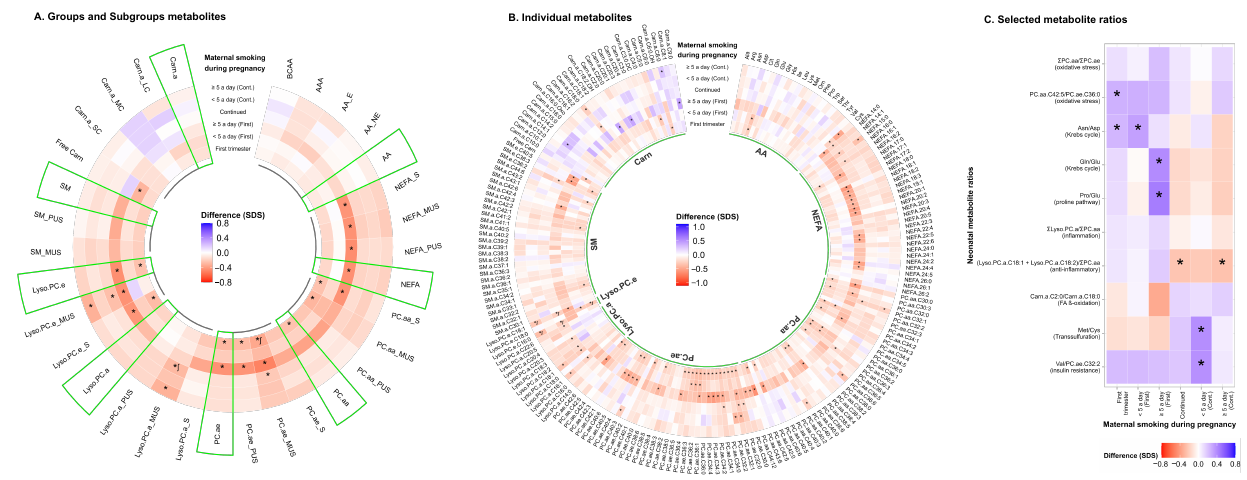
Figure 1. Associations of maternal smoking during pregnancy with cord blood metabolite profiles and ratios. Values represent regression coefficients based on linear models that reflect the positive (blue) and negative (red) difference in neonatal cord blood metabolite concentrations and ratios in standard deviation scores in neonates whose mothers smoked during pregnancy compared to mothers who did not smoke. Models were adjusted for maternal age, educational level, alcohol consumption, pre- pregnancy BMI, psychopathology symptoms, and fetal sex (confounder model). * p -value < 0.05. S Sig- nificant associations after FDR corrected p -value. The sectors of green color showed group of neonatal metabolite profile, which is preceded by metabolite profile subgroups. Abbreviations: SDS, standard deviation scores; BMI, body mass index; AA, amino acids; BCAA, branched-chain AA; AAA,